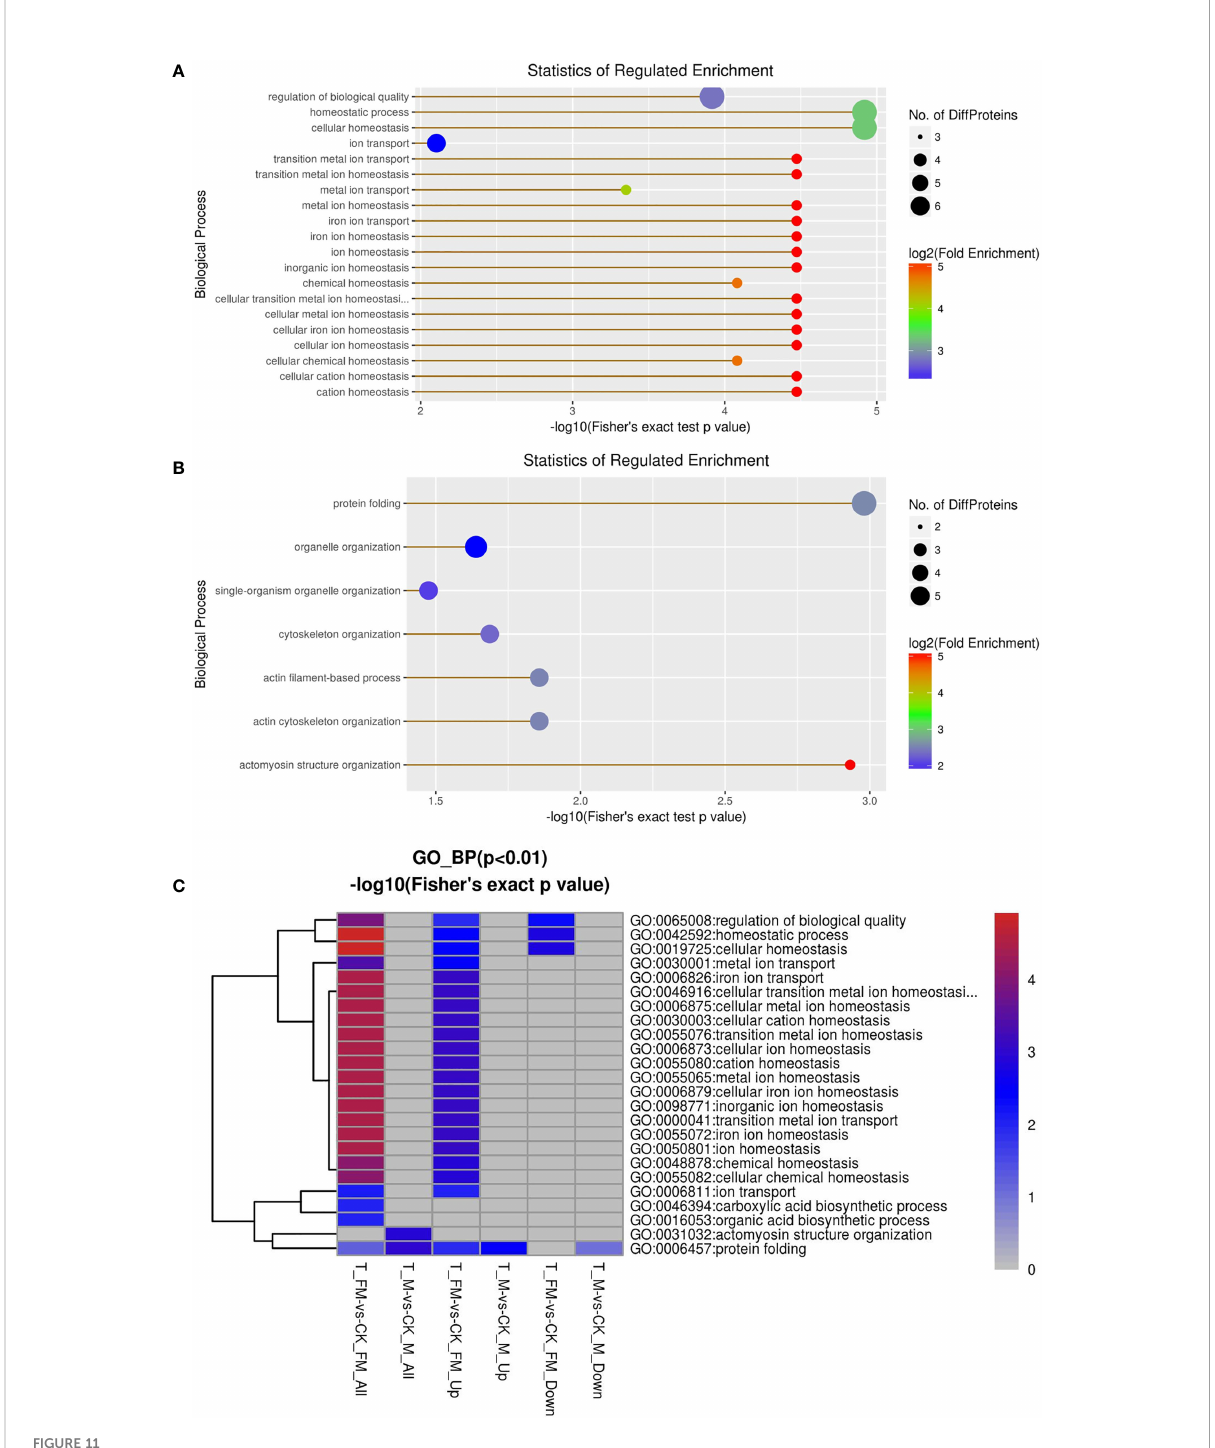
FIGURE 11 GO enrichment analysis for biological process in female (A) and male (B) adult S. japonicum